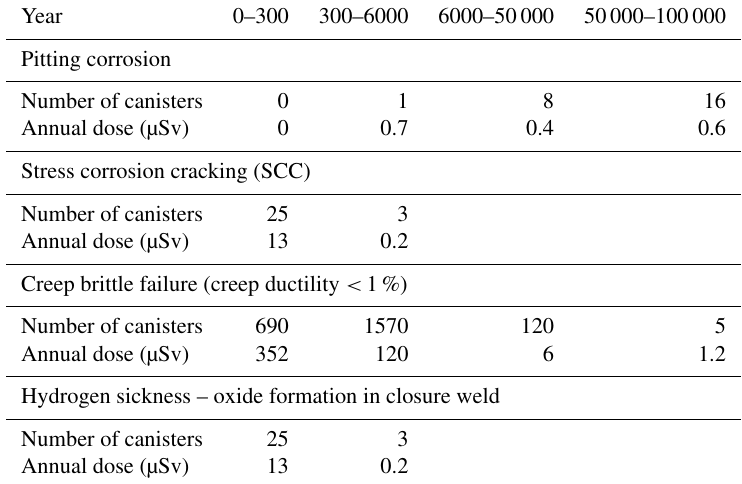
Table 1. Roughly estimated number of canister failures and annual dose after implementation and analysis of alternative canister process